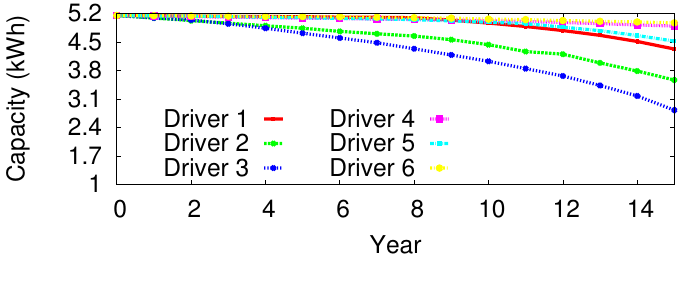
Figure 3. Expected battery system long-term aging based on six different driving